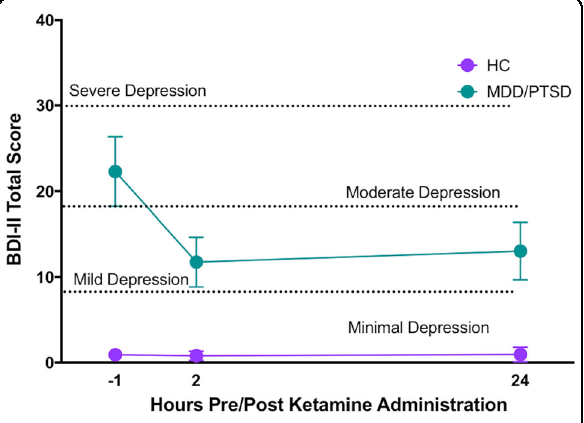
Fig. 1 Mean depression symptom severity scores (self-reported on the Beck Depression Inventory II) across timepoints in healthy control participants (HC) and participants with major depressive disorder (MDD) and posttraumatic stress disorder (PTSD). Error bars indicate 95% con fi dence intervals. Dotted lines separate categories of depression symptom severity. BDI-II Beck Depression Inventory